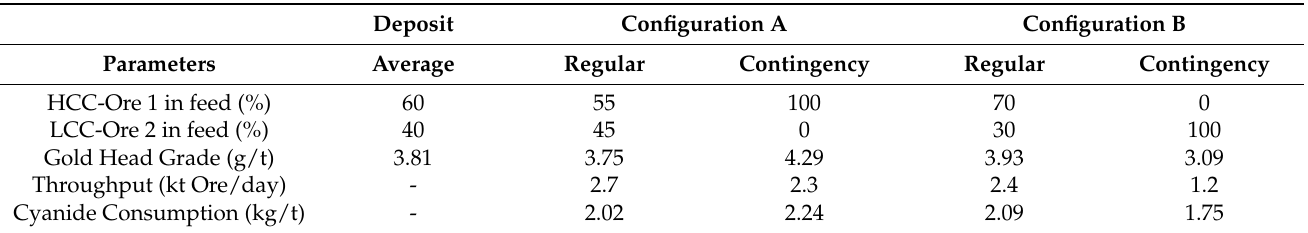
Table 7. Description of operational modes in relation to possible deposit forecast, including gold head